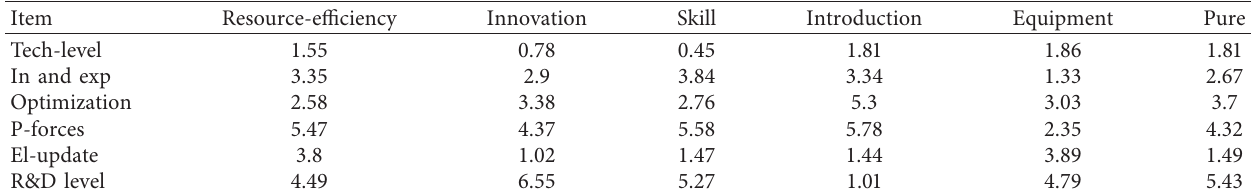
Table 4: R&D resource allocation efficiency has a greater impact.